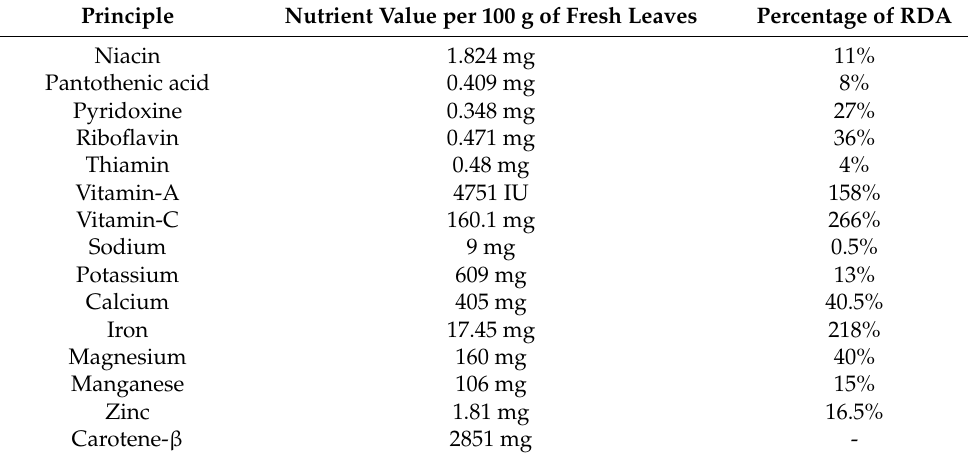
Table 2. The in-depth nutritional profile of Thymus vulgaris